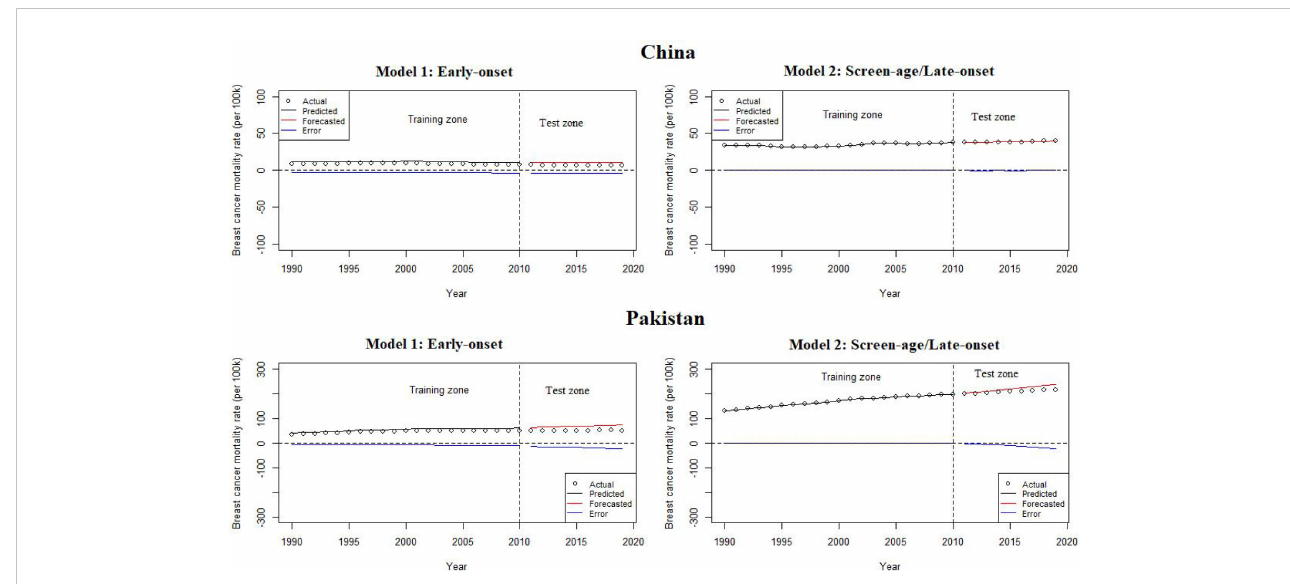
FIGURE 5 Lee – Carter model predicting ability between the early-onset and screen-age/late-onset population in China and